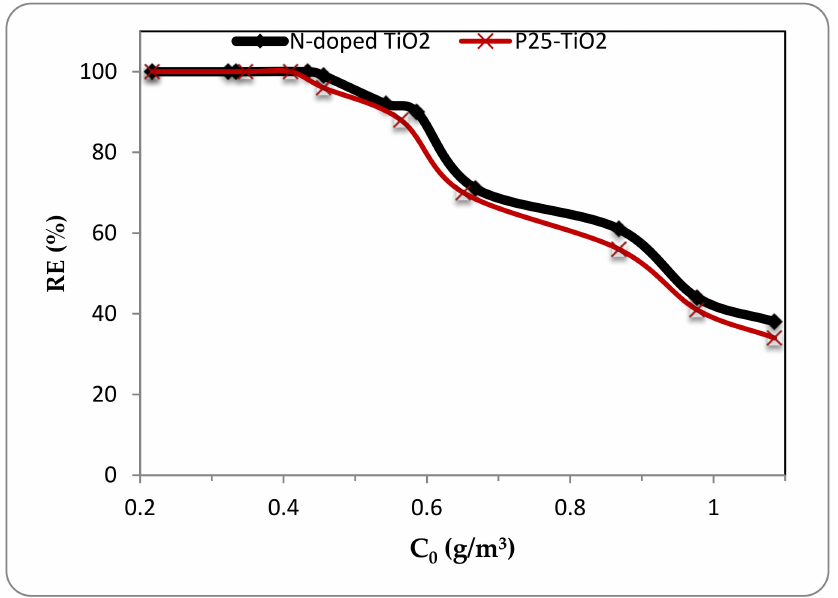
Figure 8. Effect of inlet concentration on removal efficiency at 1 min residence time under UV irradiation for N-doped and pristine TiO 2